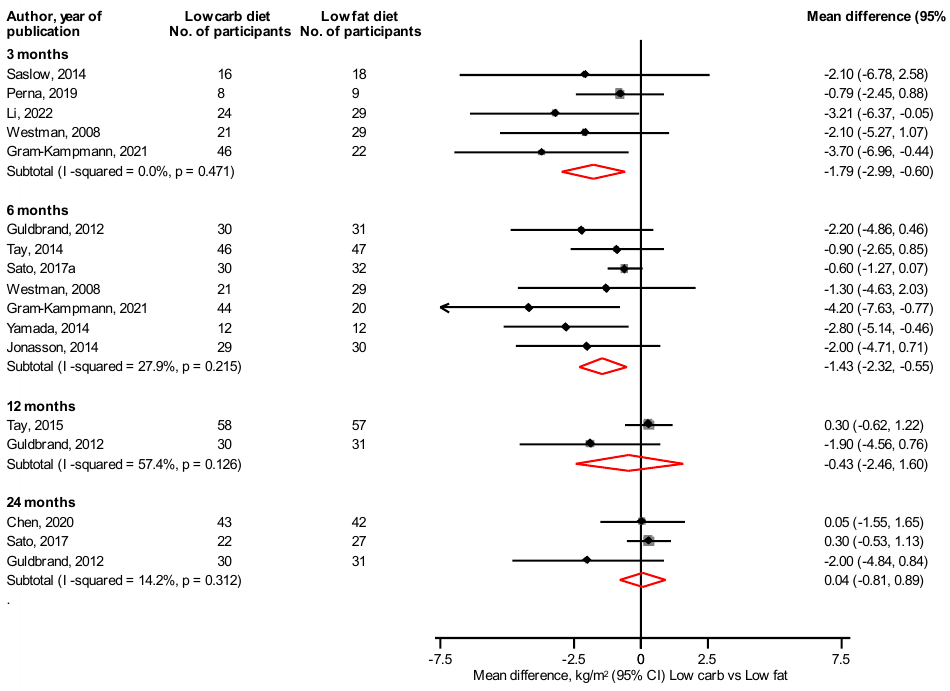
Figure 5. Low carbohydrate versus low fat diet and body mass index [31,35,37,41,43,45,46,48,50 – 54].